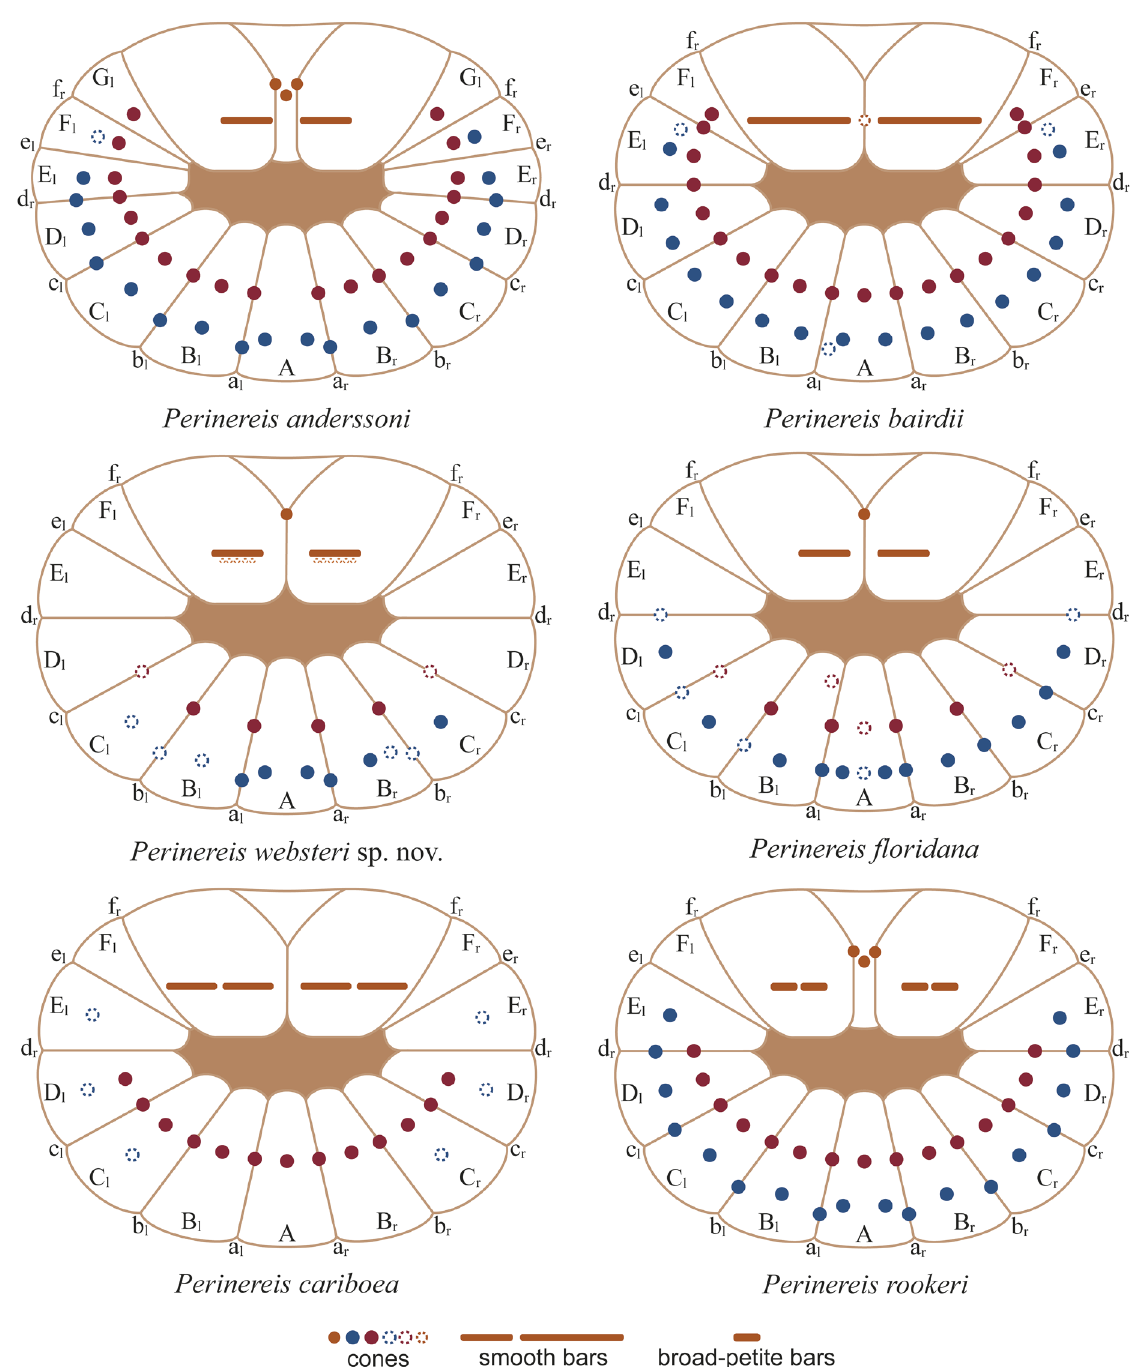
Fig. 13. Arrangement of paragnaths in the ridge and furrow regions of areas VII–VIII in species of Perinereis Kinberg, 1865. Filled figures with solid edges represent paragnaths observed in all specimens examined, no-filled figures with dashed edges represent paragnaths observed in some specimens